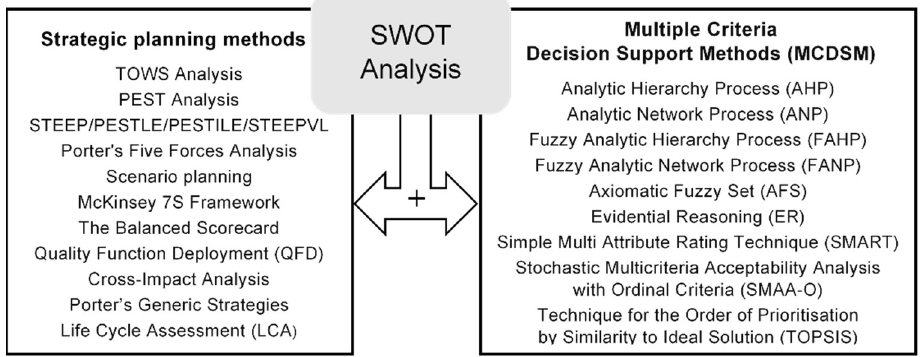
Figure 2. Selected methods and tools used in the literature in combination with SWOT analysis [24,28].